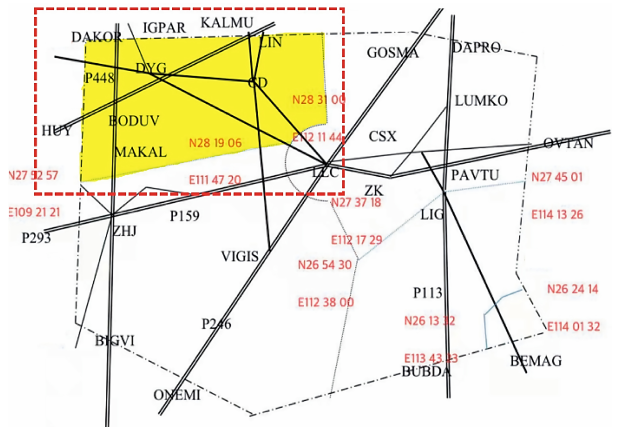
Figure 7. Structure of the target